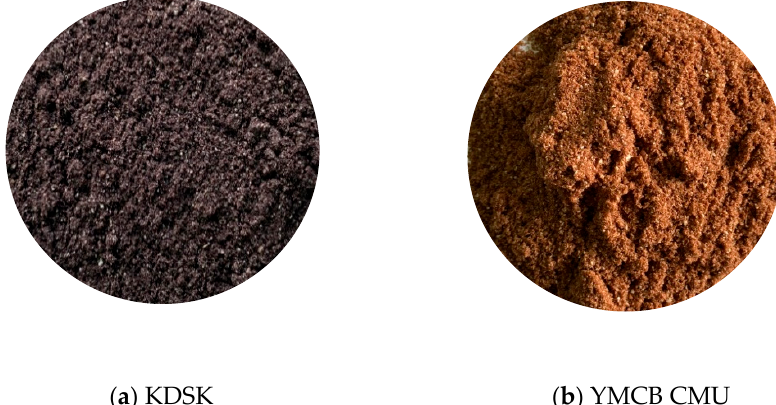
Figure 2. Rice bran characteristics derived from the 30 s polishing process of ( a ) purple rice cv. Kum Doi Saket (KDSK) and ( b ) red rice cv. Yamuechaebia Morchor (YMCB CMU).